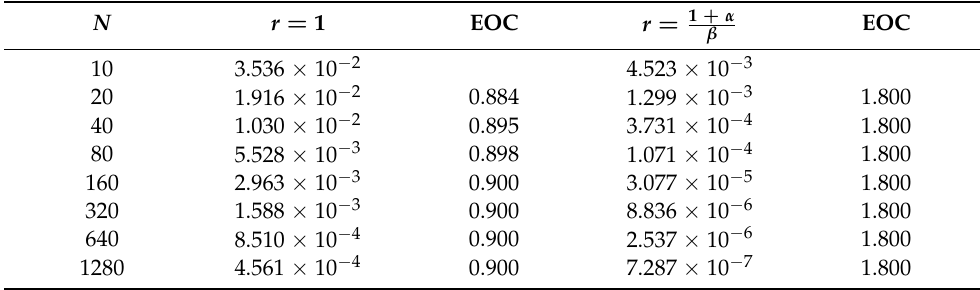
Table 4. Table showing the maximum absolute error and EOC for solving (25) using the predictor- corrector method for α = 0.8, β =